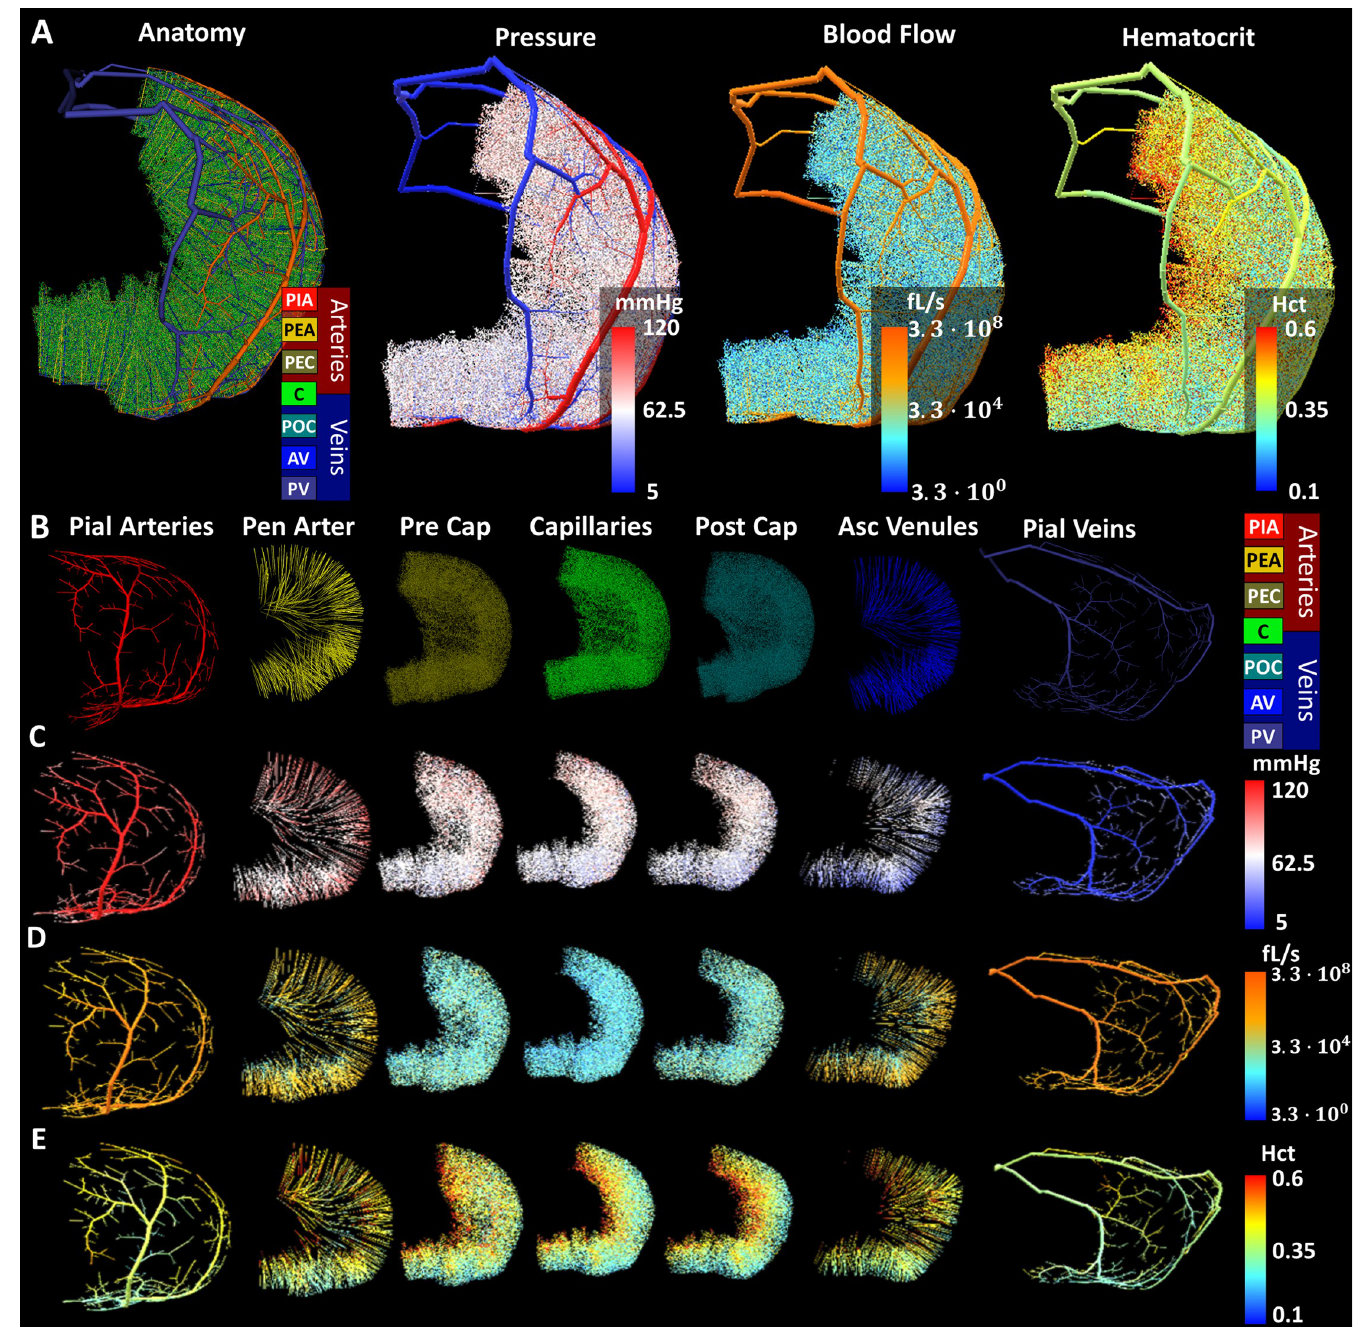
Fig 6. Blood flow of the complete arterial and venous circulation for the MCA territory in mouse. This large-scale model contains the MCA M1 segment branching from the Circle of Willis as inflow and covers the entire territory of the middle cerebral artery with a complete pial network and microvasculature encompassing PIA- pial arteries, PEA-penetrating arterioles, PEC-pre-capillaries, C-capillaries, POC-post-capillaries, AV-ascending venules, PV-pial veins. (A) Three dimensional snapshots of the spatial distribution of anatomical grouping, blood pressure, blood flow (perfusion), and hematocrit. Explosion diagram of anatomical compartments of the angioarchitecture in the MCA territory; color-coding depicts (B) anatomical groups, (C) blood pressure, (D) flow (perfusion) and (E) hematocrit distribution. This large-scale model contains 5,452 spline segments of the pial network, 27,374 splines encompassing penetrating arterioles and ascending venules, and 960,359 capillaries. The volume of the pial arteries is 143 nL (16.5%), penetrating arterioles is 75.1 nL (8.7%), precapillary arterioles is 101.9 nL (11.8%), capillaries is 96.8 nL (11.2%), post- capillary venules is 100.7 nL (11.6%), ascending venules is 75.8 (8.7%) and pial veins including portions of the superior sagittal sinus is 273.8 nL (31.5%).